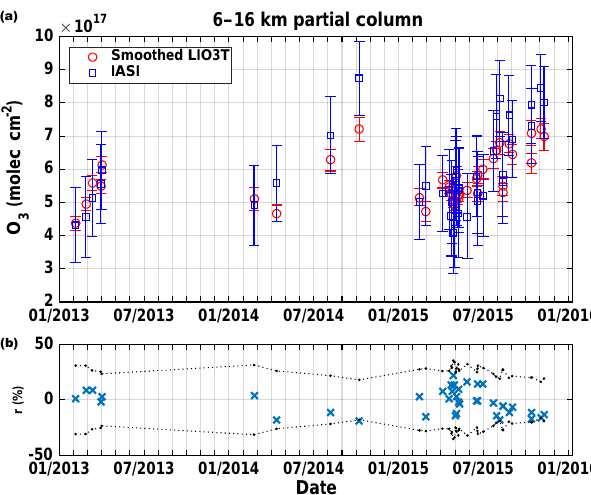
Figure 8. (a) Smoothed LIO3T (red circles) and ground-based NDACC FTIR (blue squares) 8.5–16km O 3 partial columns. Ver- tical bars give uncertainties for each measurement. (b) r (%) be- tween LIO3T and FTIR measurements (blue crosses) superimposed on LIO3T + FTIR uncertainties around zero (black dotted lines and dots).